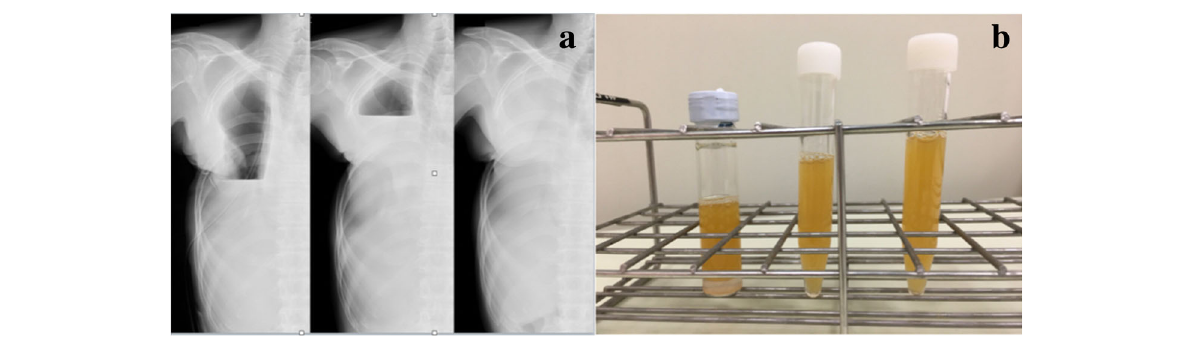
Fig. 4 Following the simple chest closure, the residual cavity was gradually filled completely with pleural effusion without any symptoms of infection ( a ). Thoracentesis demonstrated slightly cloudy and yellowish pleural effusion, and P. aeruginosa was cultured from the fluid ( b